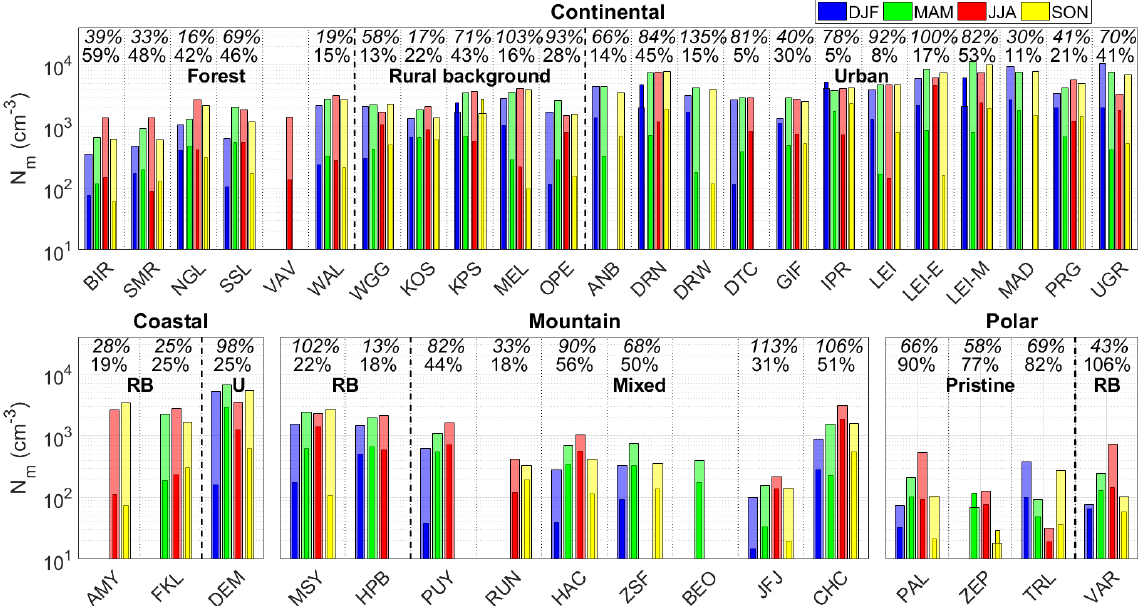
Figure 8. Modal concentrations. For each site and season, the thicker bar represents the modal concentration of the Aitken mode ( N m , 1 ) and the thinner one that of the accumulation mode ( N m , 2 ). The values at the top of each panel indicate the site-specific variability of the modal concentrations, with the italicized text corresponding to N m , 2 . The meaning of the abbreviations used for the footprint is the following: RB for rural background and U for urban. Details regarding the calculation of the site-specific variability of the mode characteristics are available in Sect. 5.1.